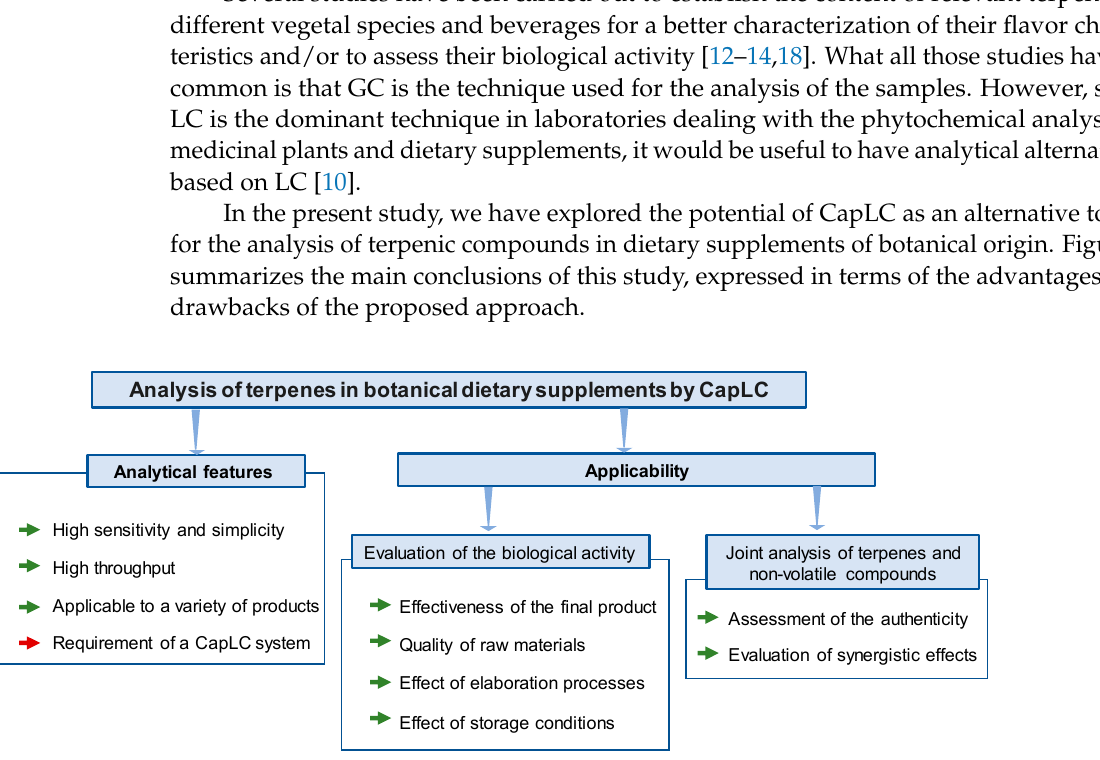
Figure 4. Analytical features and applicability of the method developed for the analysis of terpenes in botanical dietary supplements by CapLC; strengths in green; weaknesses in red.